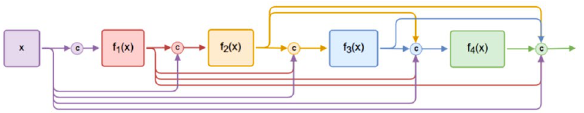
Figure 2. Dense connections in DenseNet (this figure was created with Draw.io).